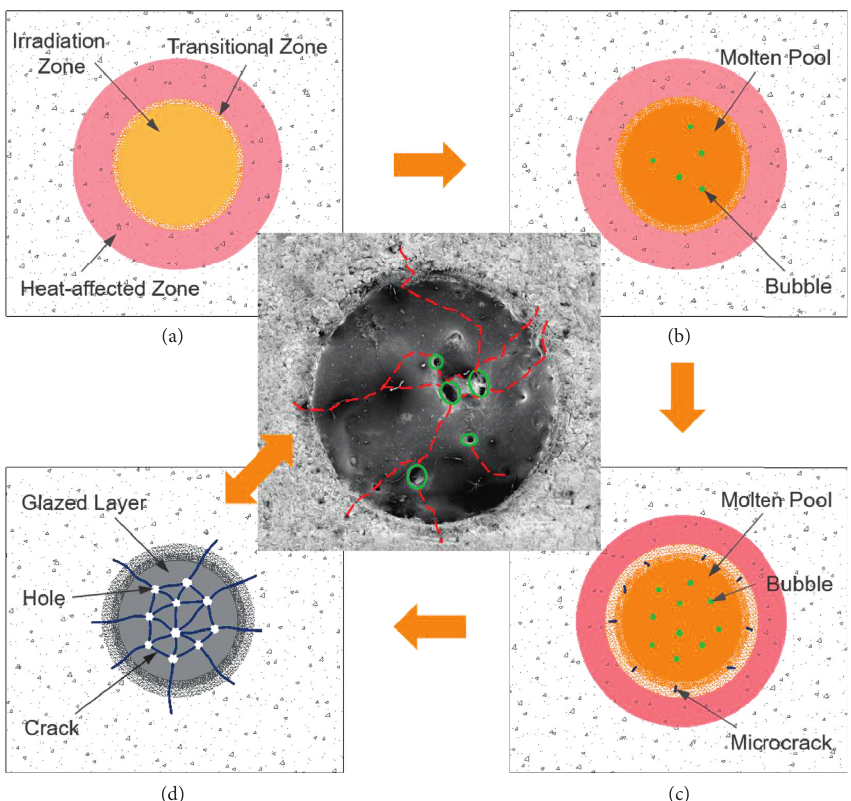
Figure 6: Schematic diagram of failure process of the rock by fiber laser irradiation.